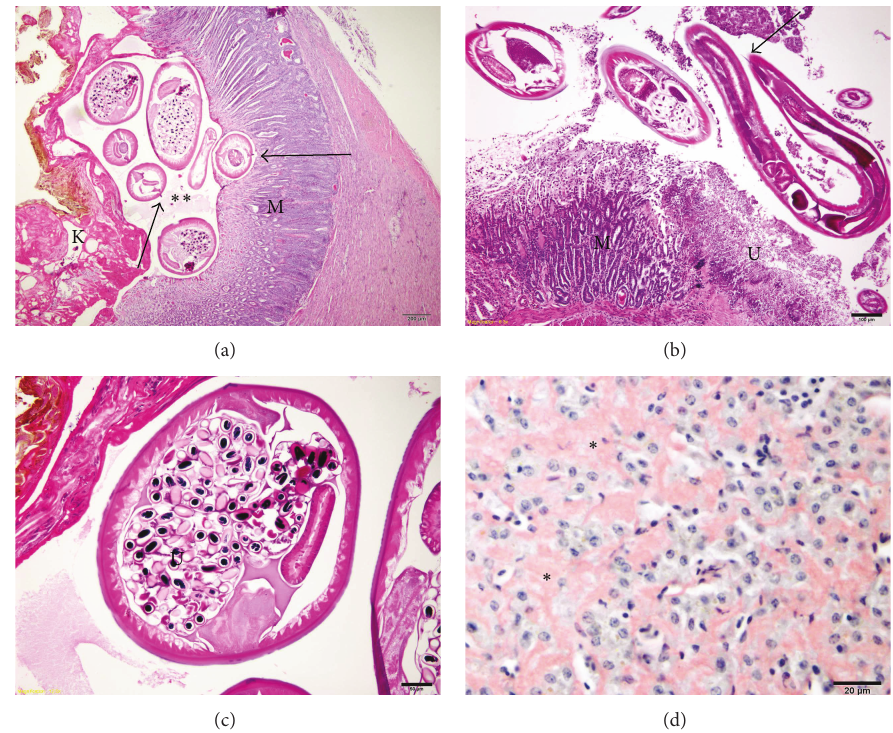
Figure 2: (a) Lower power view of ventriculus from L. lutea . Multiple cross-sections of Procyrnea sp. nematodes (asterisks) with lateral alae (arrows) are visible between the mucosa and fragmented koilin layer (H&E stain). M: mucosa; K: koilin layer. Scale bar = 200 𝜇 m. (b) Higher power view of the ventriculus from a more severely affected Z. japonicus . The koilin layer above the Procyrnea sp. nematodes is largely absent and there is regionally extensive mucosal ulceration which is covered with a mat of fungal hyphae admixed with fibrin and cell debris. The posteriorspiculefromamalenematode(arrow)iscapturedinlongitudinalsection(H&Estain).M:mucosa;U:ulceration. Scalebar=100 𝜇 m. (c) Cross-section through a female Procyrnea sp. nematode from a Z. japonicus containing large numbers of larvated, thick-shelled eggs (H&E stain). U: uterus. Scale bar = 50 𝜇 m. (d) Large sinusoidal accumulations of brightly eosinophilic amyloid (asterisks) compress the